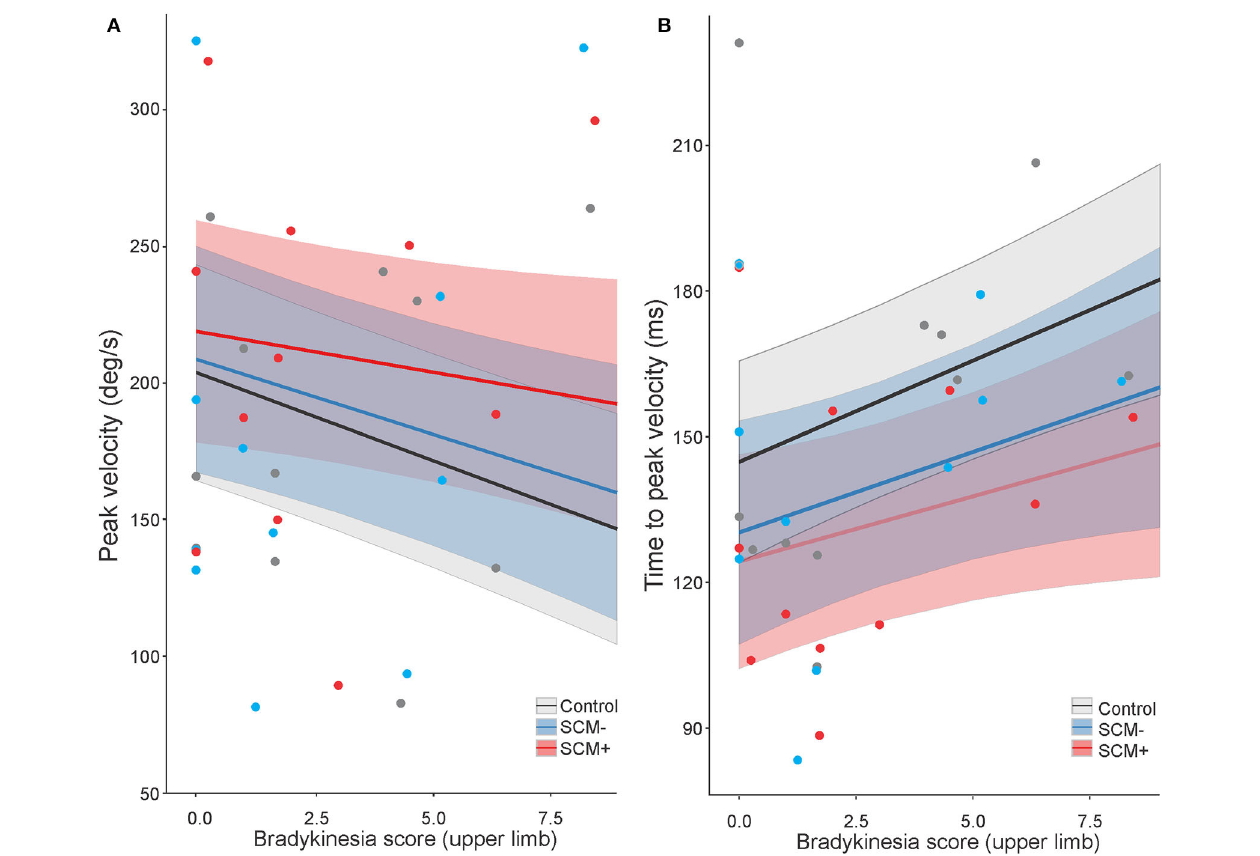
FIGURE 4 | Model-fitted predicted peak velocity (A) and time-to-peak velocity (B) for the elbow-extension task as a function of a bradykinesia score. The black lines show predicted values for control trials, the red lines show predicted values for startle trials where a startle reflex in sternocleidomastoid (SCM) was observed (SCM + ), and the blue lines show predicted values for startle trials where a startle reflex was not observed (SCM–). Shaded areas represent 95% CI. In all auditory stimulus conditions, higher bradykinesia scores predicted lower peak velocities (A) and longer time-to-peak velocity (B) . SCM + trials predicted higher peak velocities than SCM– trials and control trials (A) , whereas both SCM + and SCM– trials predicted shorter time to peak velocity compared to control trials (B) . Dots represent participant mean values (note that these means are collapsed across tDCS sessions, which may have had different BK scores, and the model takes all individual data points into